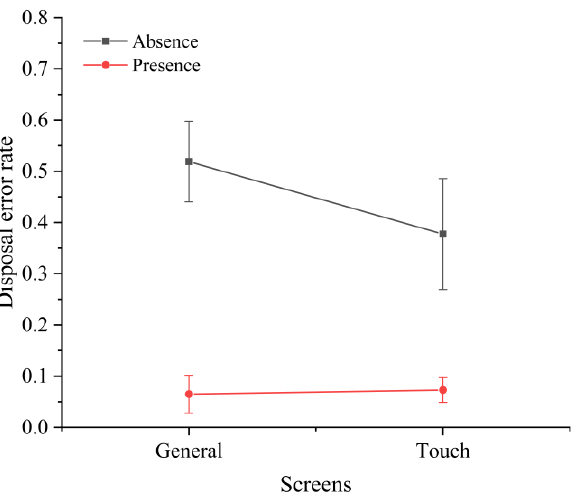
Figure 7. Interaction effect between screen type and time pressure on the disposition error rate.